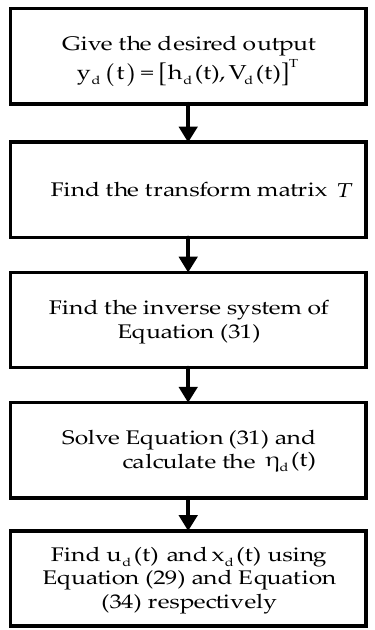
Figure 3. Flowchart of the SI algorithm.